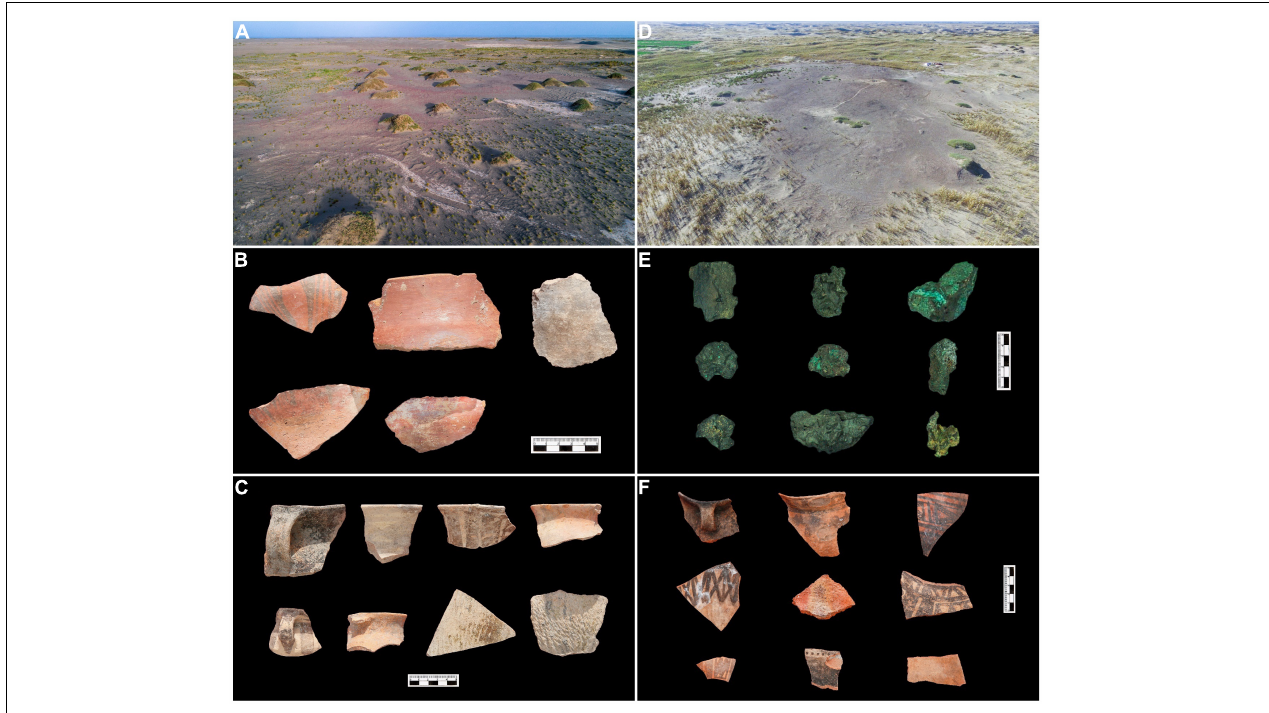
FIGURE 2 | Images of the archeological sites and their cultural relics. (A) Aerial photo of Ganggangwa site. (B) Pottery sherds of Late Machang Culture unearthed from Ganggangwa site (T1911F2). (C) Pottery sherds of Xichengyi Culture unearthed from Ganggangwa site (T1911L3). (D) Aerial photo of Huoshiliang site. (E) Bronze slags unearthed from Huoshiliang site (T1007L3). (F) Pottery sherds of Xichengyi Culture unearthed from Huoshiliang site (T1007H33).